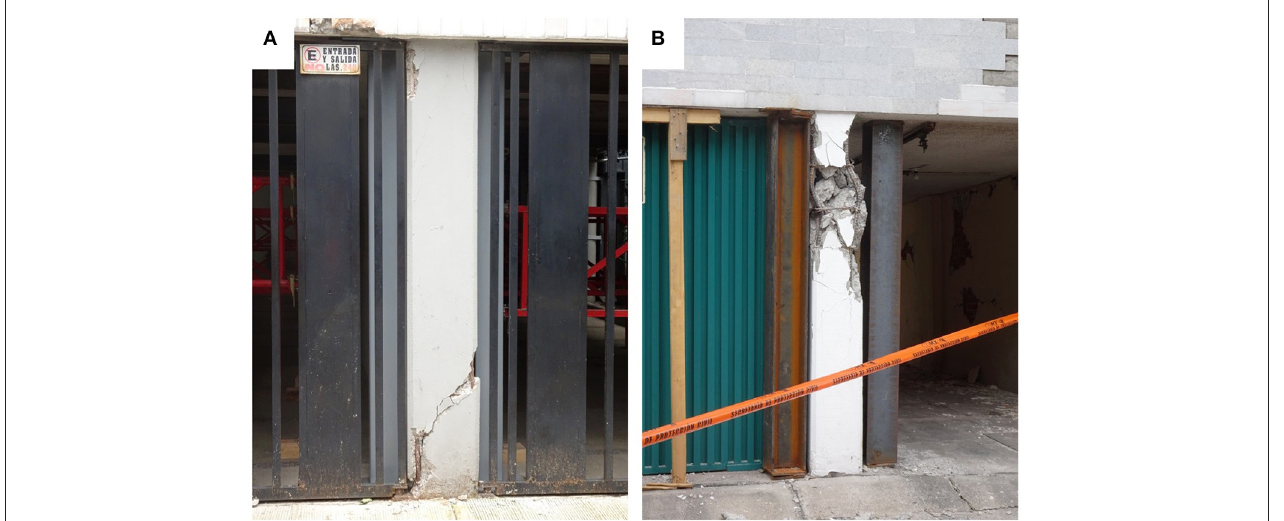
FIGURE 12 | (A) Failure of the column in shear. (B) Buckling of the longitudinal reinforcement bars.